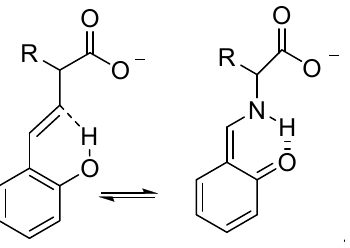
Figure 4. Ionic liquids based on amino acids.